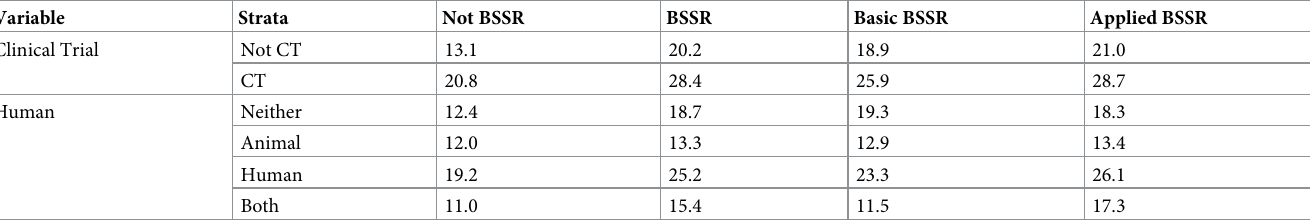
Table 1. Time to first publication (months) by BSSR or not and by CT and human subject codes. Variable Clinical